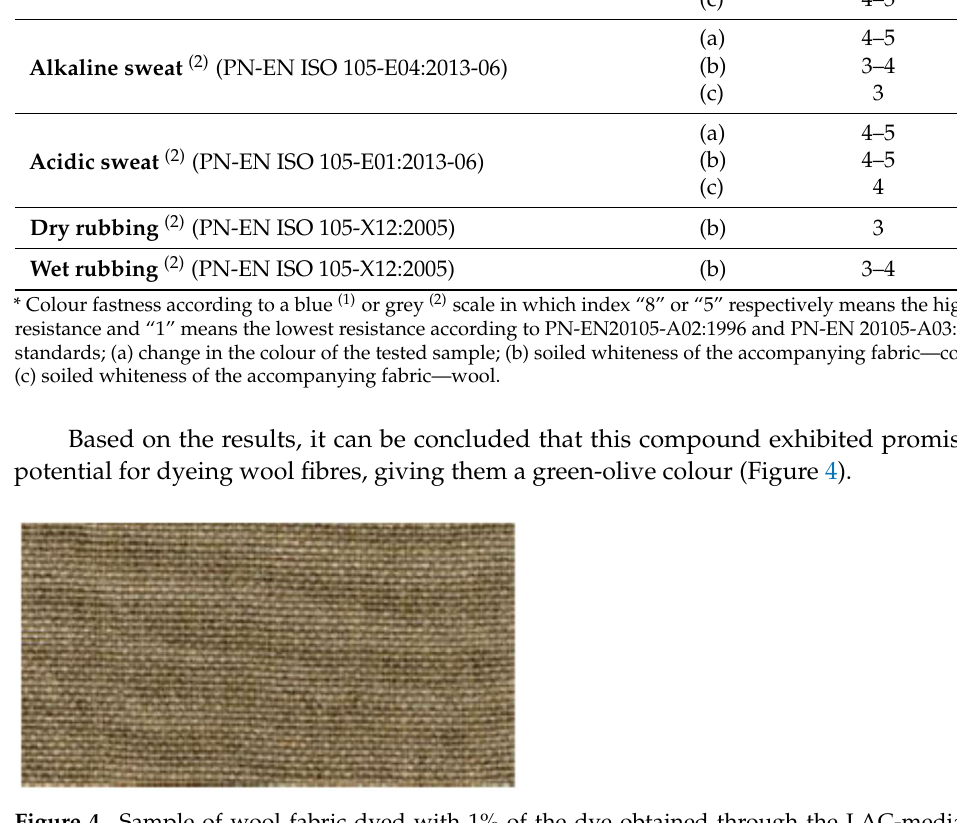
Figure 4. Sample of wool fabric dyed with 1% of the dye obtained through the LAC-mediated oxidation of ANS substrate.